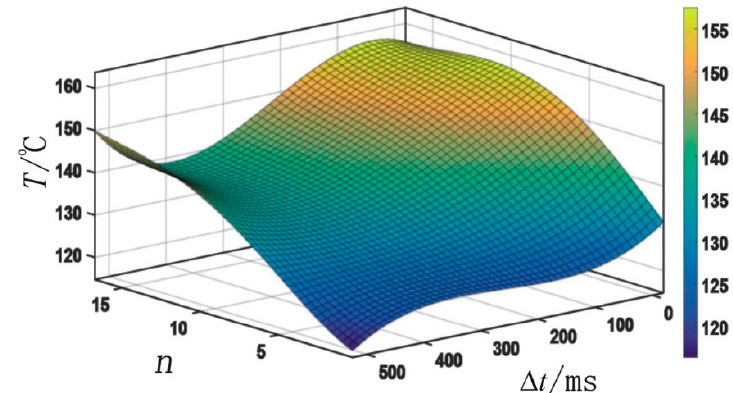
Figure 10. Average temperature rise of the ZnO varistor surface under five pulses.